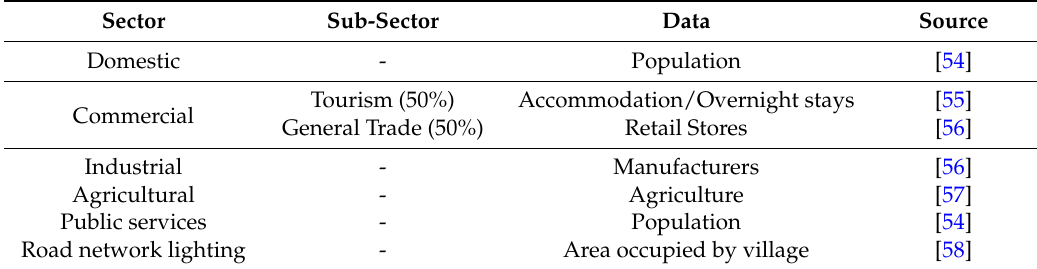
Figure 5. Annual energy consumption per municipality for the year 2012. Table 2. Electricity consumption reduction (electricity demand) at village and agricultural land level, year 2012 [53].